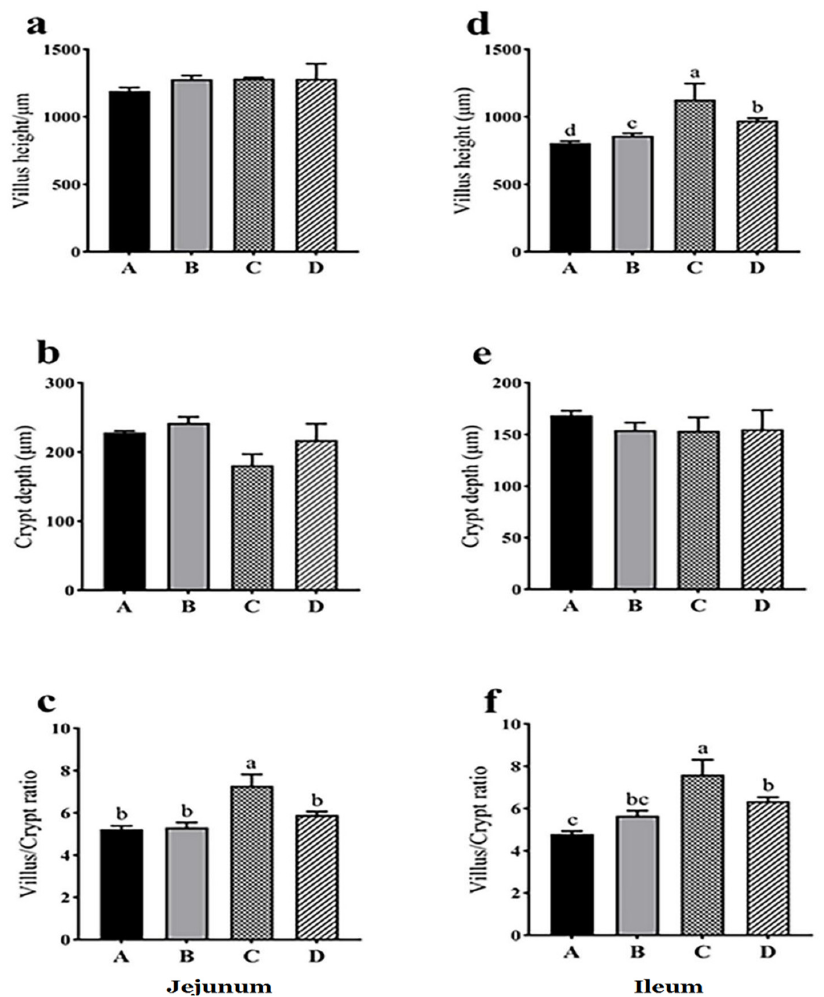
Figure 2. Effects of dietary probiotics on jejunal ( a – c ) and ileal ( d – f ) histomorphology of geese at the age of 70 days. Note: a and d for villus height, b and e for crypt depth, c and f for the ratio of villus height to crypt depth. Group A (as control) was fed a basal diet, treatment groups (B, C and D) were fed the basal diet supplemented with 250 mg/kg Clostridium butyricum (viable count 3.0 × 10 6 CFU/g), 250 mg/kg Bacillus subtilis (viable count 2.0 × 10 7 CFU/g), or the combination of 250 mg/kg Clostridium butyricum plus 250 mg/kg Bacillus subtilis , respectively. n = 6. Different letters above the bars indicate significant differences between the groups ( p < 0.05). The data are presented as the mean ±